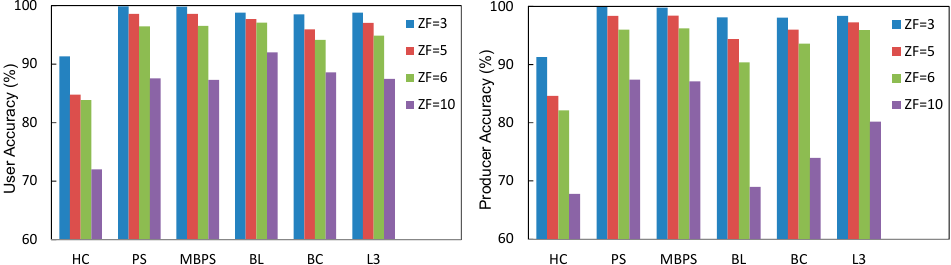
Figure 17. User and producer accuracies of hard classification and SRM algorithms using semi-simulated water fractions across a range of ZF for Sarca River; (HC: hard classification, PS: pixel swapping, MBPS: modified binary PS, BL: bilinear, BC: bicubic, L3: lanczos3).